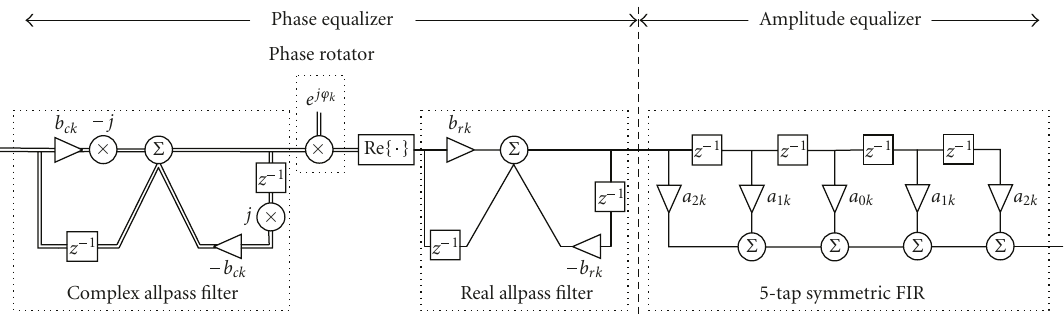
Figure 6: An example of the AP-FBEQ subband equalizer